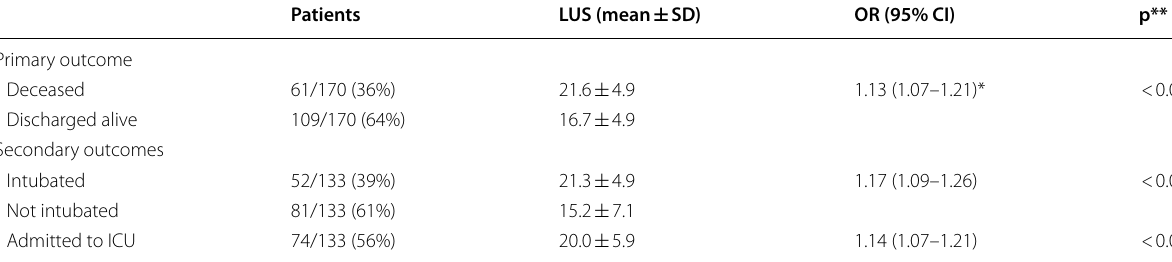
* Adjustment for age did not change results ** p-values calculated by Student’s t-test